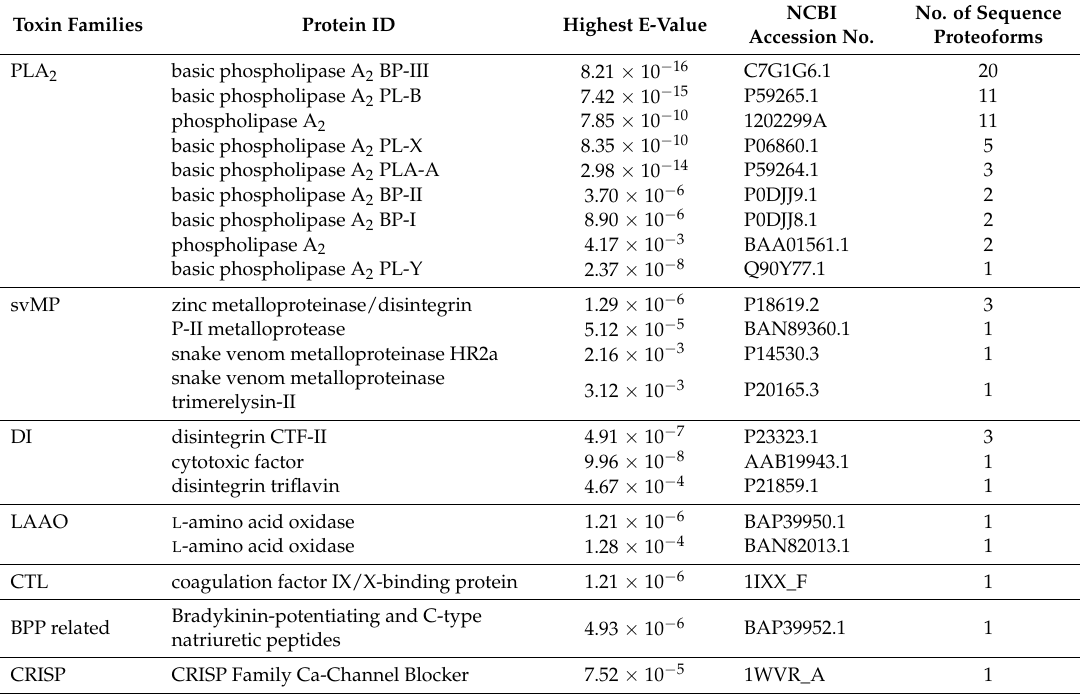
Table 1. Identified proteoforms and fragments of P. flavoviridis venom by reduced top-down analytics. Assignment of reduced crude venom components by a top-down (TD) analysis. Sequence tags were obtained de novo from MS/MS spectra and identified against a P. flavoviridis National Center for Biotechnology Information (NCBI) protein database (taxid: 88087) by